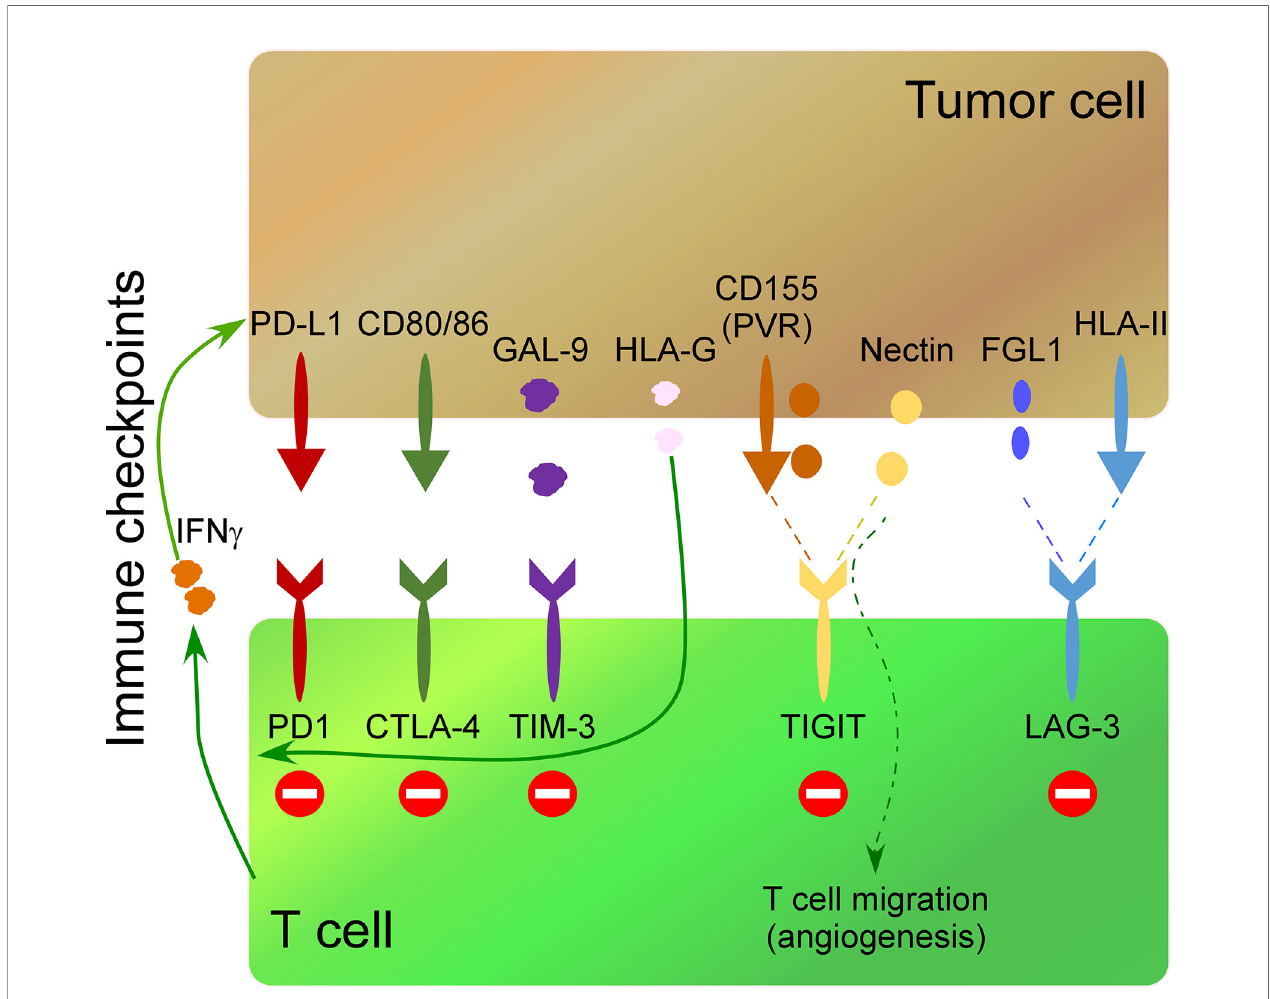
FIGURE 2 | Impact of some secreted molecules in the TME on the expression of immunocheckpoints in T cells. The most common immune checkpoints on T cells include programmed death 1 (PD-1), cytotoxic T lymphocyte antigen 4 (CTLA-4), T cell immunoglobulin and mucin-3 (TIM-3), T cell immunoglobulin and ITIM domain (TIGIT) and lymphocyte activation gene 3 (LAG3), which interact with their ligands on tumor cells. IFN g release by activated T cells induces PD-L1 up-regulation in tumor cells. TIM-3 interaction on Th1 cells with Galectin-9 (Gal-9) on tumor cells inhibits Th1 cell responses. Soluble HLA-G released by tumor cells up-regulates PD-1, CTLA-4, and TIM-3, on T cells. CD155 (PVR), and the Nectin family are ligands of TIGIT. Soluble PVR is released by tumor cells. Soluble Nectins released by cancer cells mediate transendothelial migration of immune cells promoting angiogenesis. HLA-II over-expression by tumor cells and fi brinogen-like 1 (FGL1) secreted by tumor cells impact the expression of LAG-3 in T